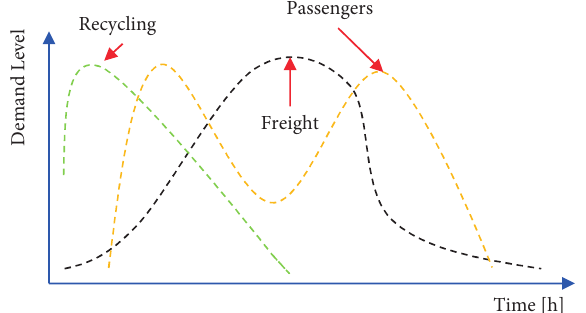
Figure 1: Example demand distribution for passengers, freight, and recycling in an urban